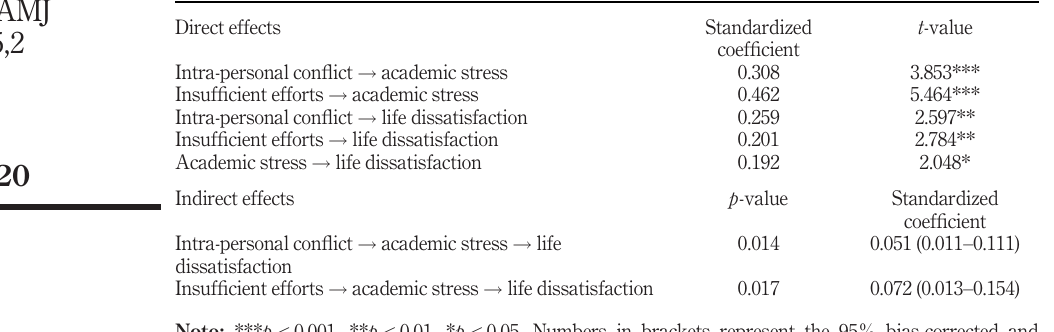
Table 2. Mediation